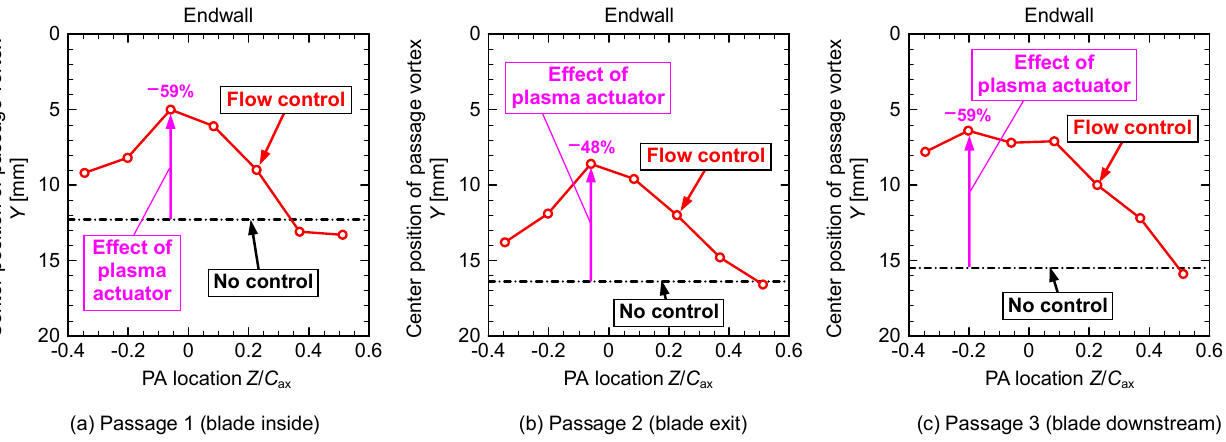
Figure 21. Effect of the plasma actuator location on the center position of the passage vortex (Re out = 3.7 × 10 4 ).